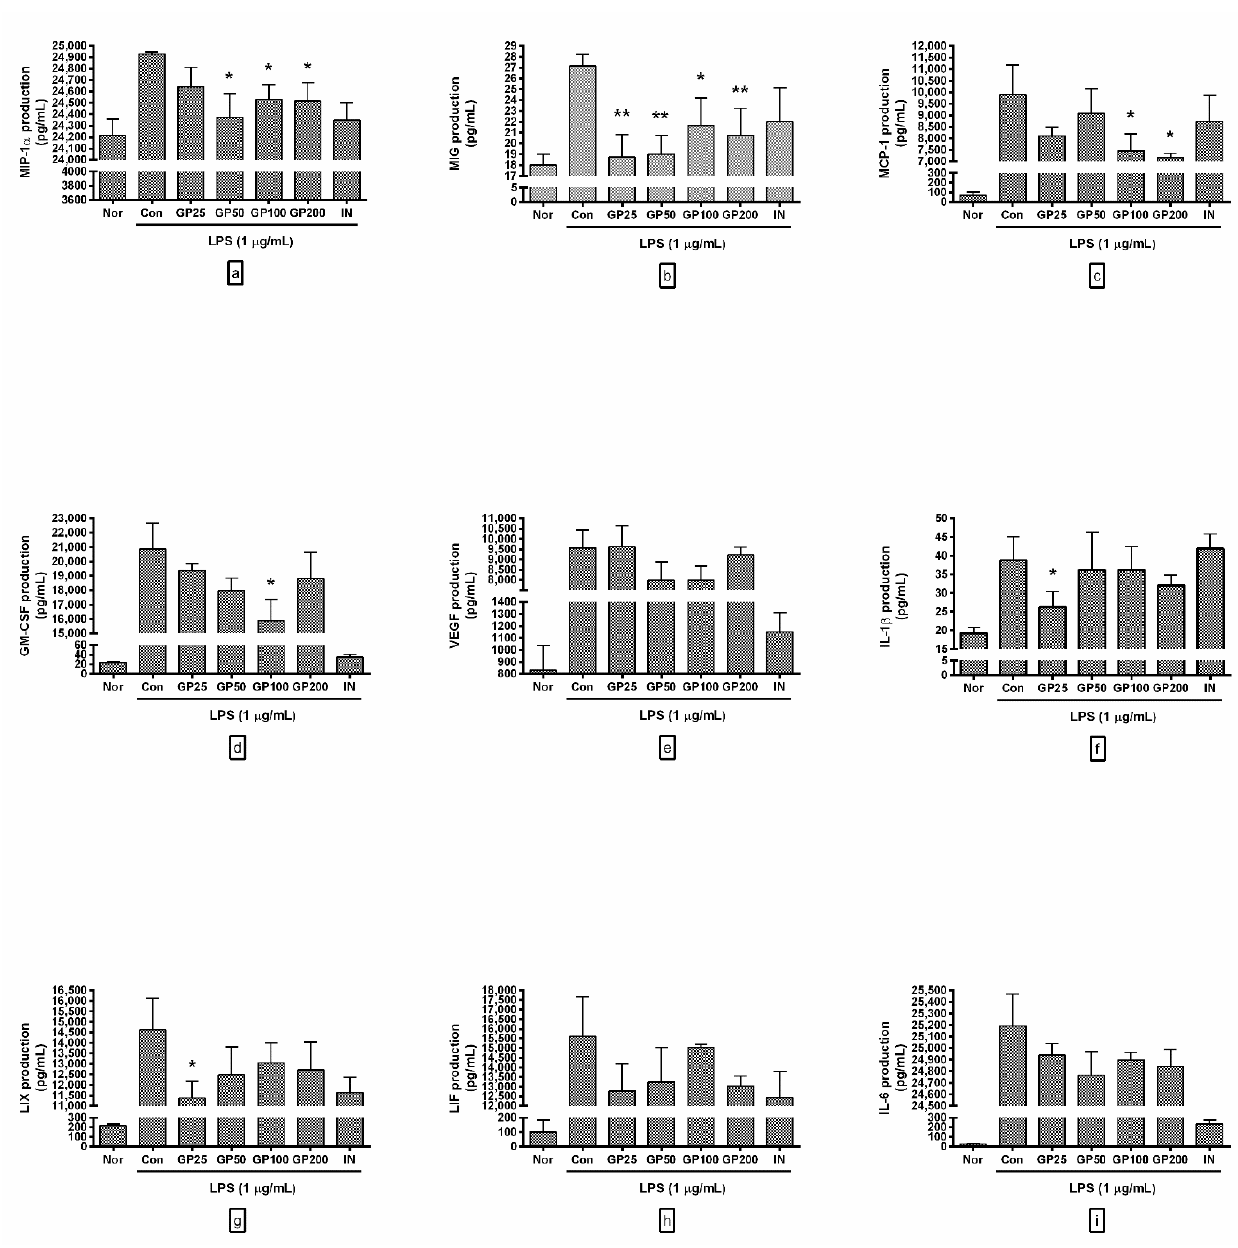
Figure 2. Effects of a combination extract of Gardeniae Fructus and Perillae Folium (GP) on productions of MIP-1 α (CCL-3) ( a ); MIG (CXCL9) ( b ); MCP-1 (CCL2) ( c ); GM-CSF (CSF2) ( d ); VEGF ( e ); IL-1 β ( f ), LIX (CXCL5) ( g ); LIF ( h ), and IL-6 ( i ) in LPS-activated RAW 264.7. Each cytokine in the culture medium was measured by a Multiplex cytokine assay. Values are the mean ± SD of the three independent experiments. Nor, normal group (media only); Con, control group (LPS alone); IN, indomethacin (0.5 µ M). GP25, GP50, GP100, and GP200 indicate 25, 50, 100, and 200 µ g/mL of GP, respectively. * p < 0.05 vs. Con; ** p < 0.01 vs. Con.